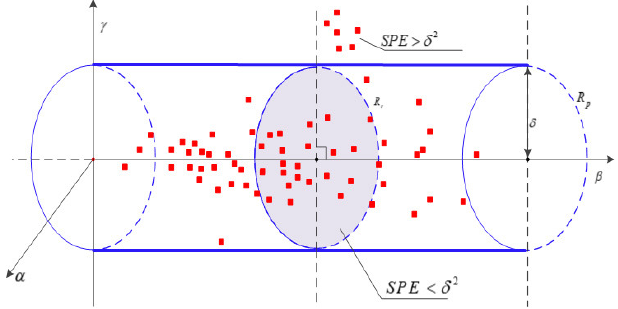
Figure 3. Geometric schematic of fault detection based on SPE (Squared prediction error)